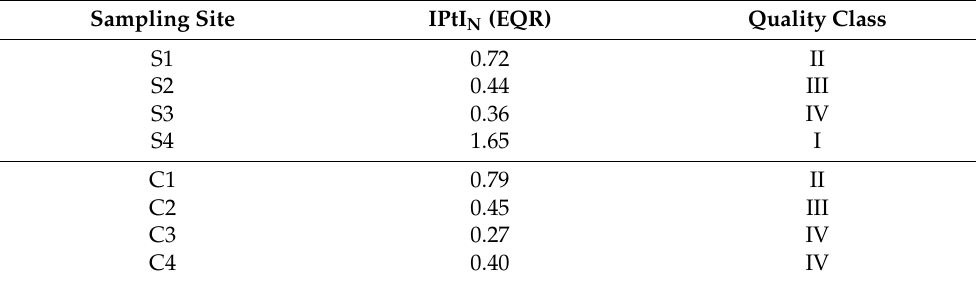
Table 2. Spatial variation of the IPtI N (North Invertebrate Portuguese Index) and the respective ecological quality class of the sampling sites of Selho (S1 to S4) and Costa-Couros (C1 to C4) rivers. Sampling Site IPtI N (EQR) Quality Class S1 0.72 II S2